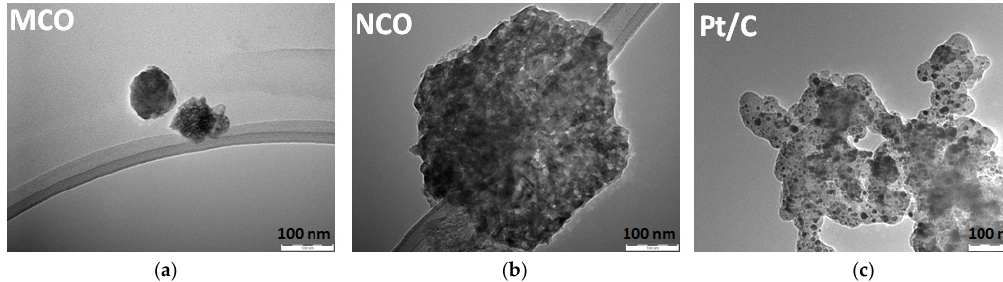
Figure 3. TEM images of as-prepared ( a ) MnCo 2 O 4 (MCO), ( b ) NiCo 2 O 4 (NCO), and ( c ) as-received Pt/C from commercial EC 20 GDE. Table 1. Physical properties of bifunctional catalysts.